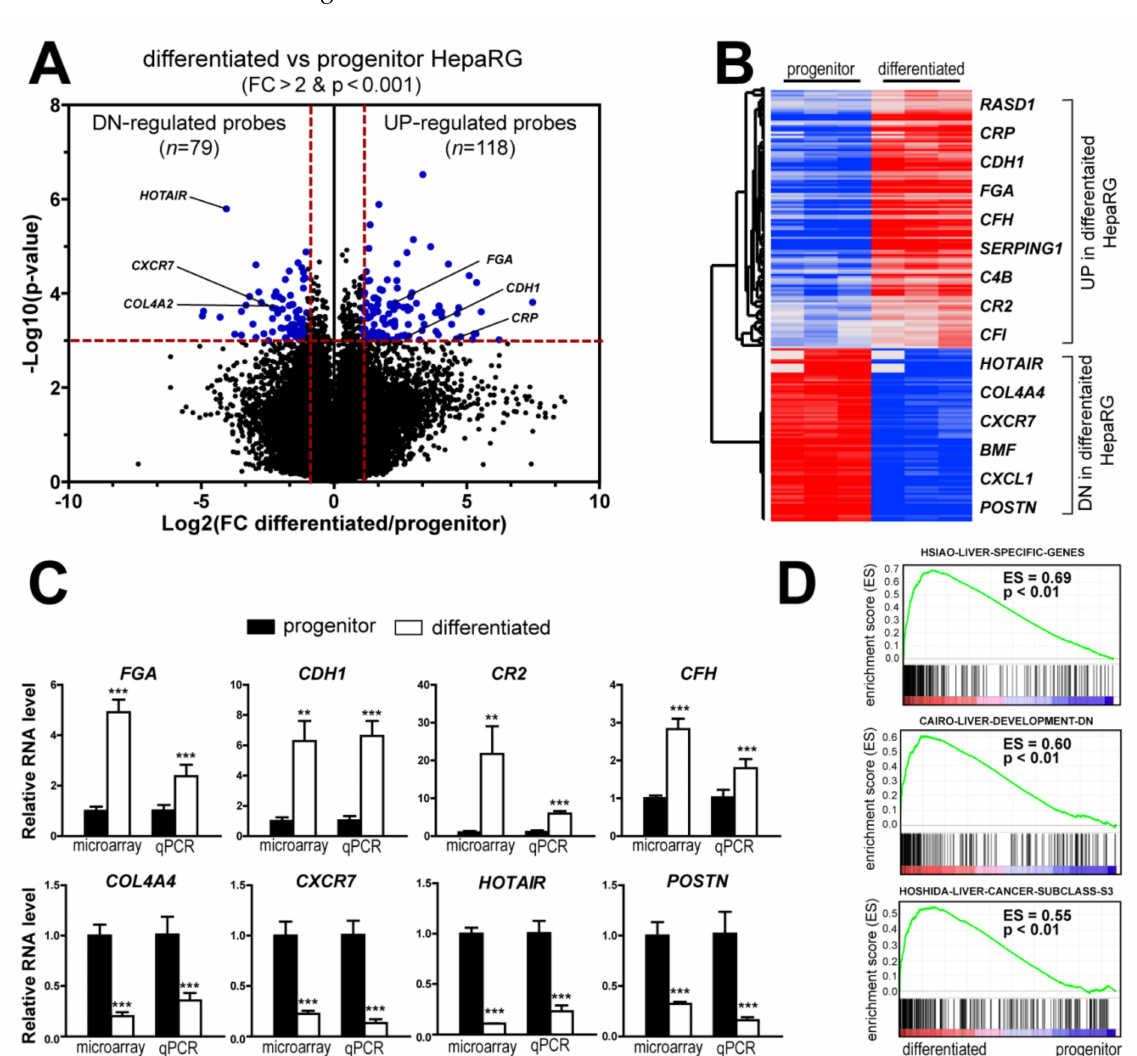
Figure 2. Differentiated and progenitor HepaRG cells exhibit distinct gene expression profiles related to hepatocyte differentiation. ( A ) Volcano plot of genes differentially expressed between differentiated and progenitor HepaRG cells. Differentiated HepaRG cells display a specific signature of 118 probes (105 genes) up-regulated and 79 probes (69 genes) down-regulated. Horizontal dashed red line: p < 0.001. Vertical dashed red lines: FC > 2. ( B ) Hierarchical clustering analysis and examples of genes up- and down-regulated in differentiated and progenitor HepaRG cells. The complete list of probes and genes is provided in the Supplementary Table S1. ( C ) Gene expression analysis of representative genes differentially expressed in differentiated and progenitor HepaRG cells, as determined by microarray and qRT-PCR. Statistical analysis was performed by a Mann–Whitney test (** p < 0.01, *** p < 0.001, n ≥ 3). ( D ) GSEA analysis using the gene expression profiles of differentiated (left side) and progenitor (right side) HepaRG cells. GSEA highlights a significant enrichment ( p < 0.01) of several liver-related signatures, including the so-called HSIAO_LIVER_SPECIFIC_GENES